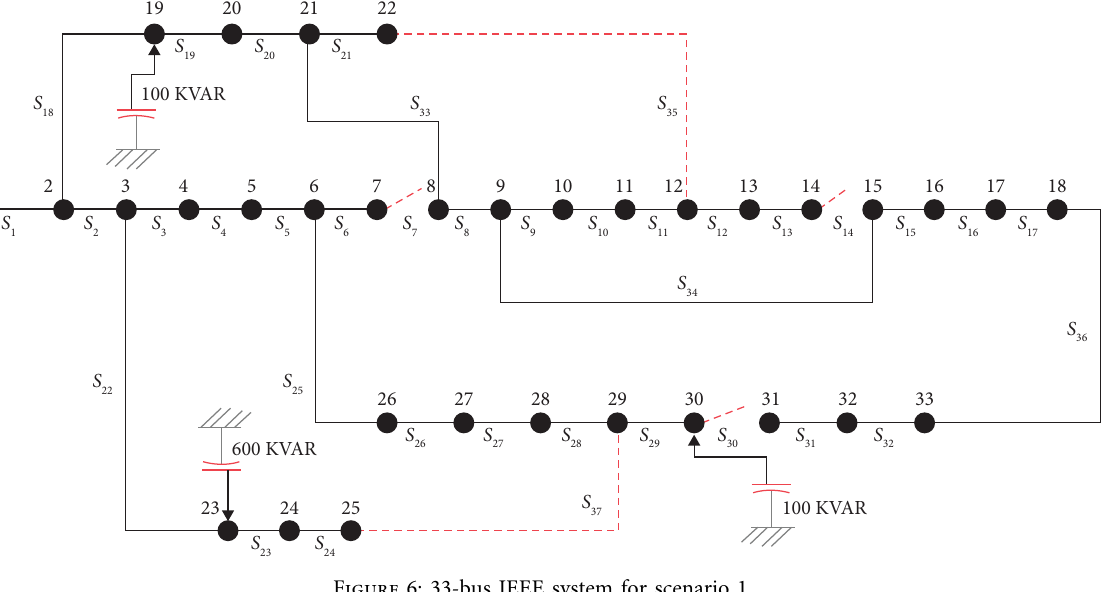
Figure 6: 33-bus IEEE system for scenario 1.